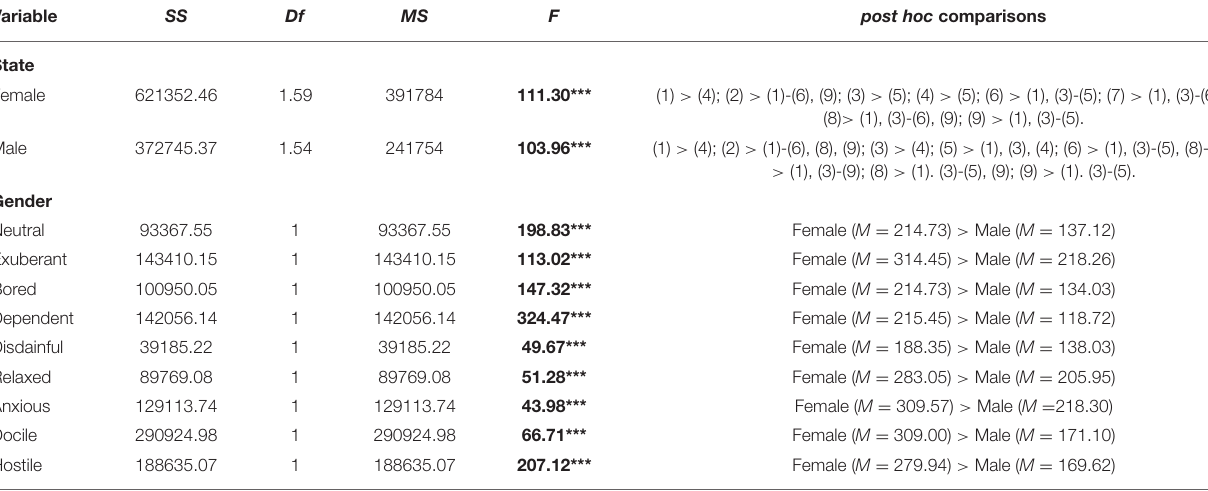
TABLE 4 | Two-way ANOVA abstract of emotional states and gender on velocity. Variable